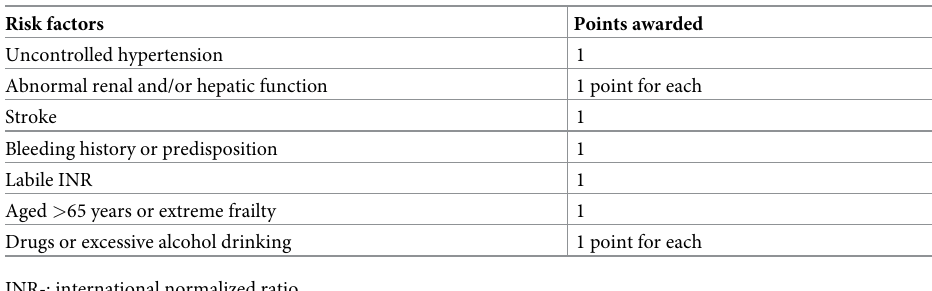
Table 2. HAS-BLED score